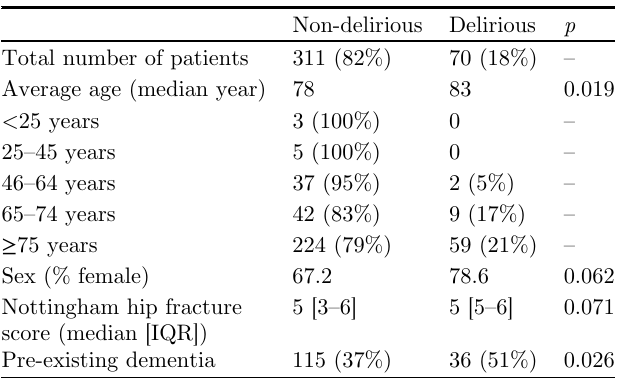
Table 2. Patient